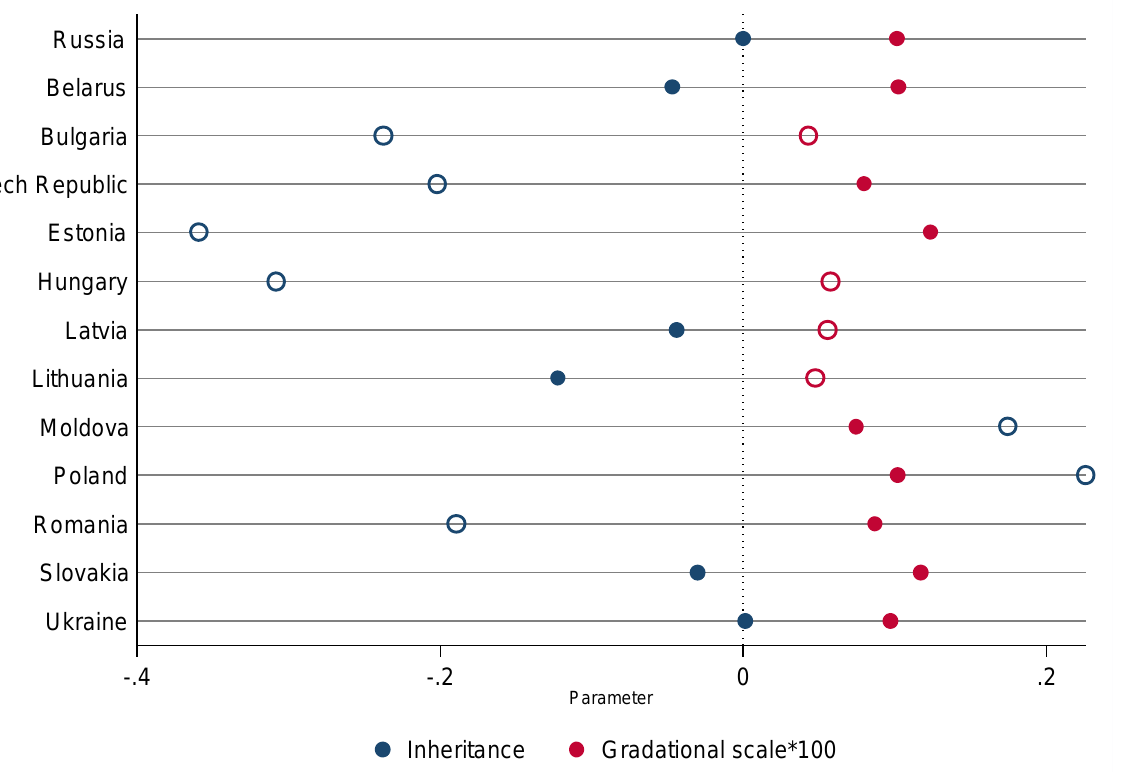
Figure 2: Parameters from model 7 for uniform inheritance and gradational mobility for each country (Russia takes the values of the UI and GS terms, UI here set to 0; other countries then plotted using UI*C and GS*C terms). Hollow circles indicate significant differences from reference category of Russia ( p <